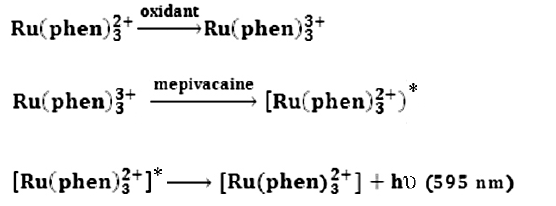
SO , and c) Ru(phen) 32+ . Other conditions: mepivacaine concentration was 45.25 μg 2 4 SO (0.08 mol L –1 ); b) Ru(phen) 32+ (2.0 × 10 –3 mol L –1 ), Ce(IV) (5 × 10 –3 mol L –1 ); c) Ce(IV) (5 × 10 2 4